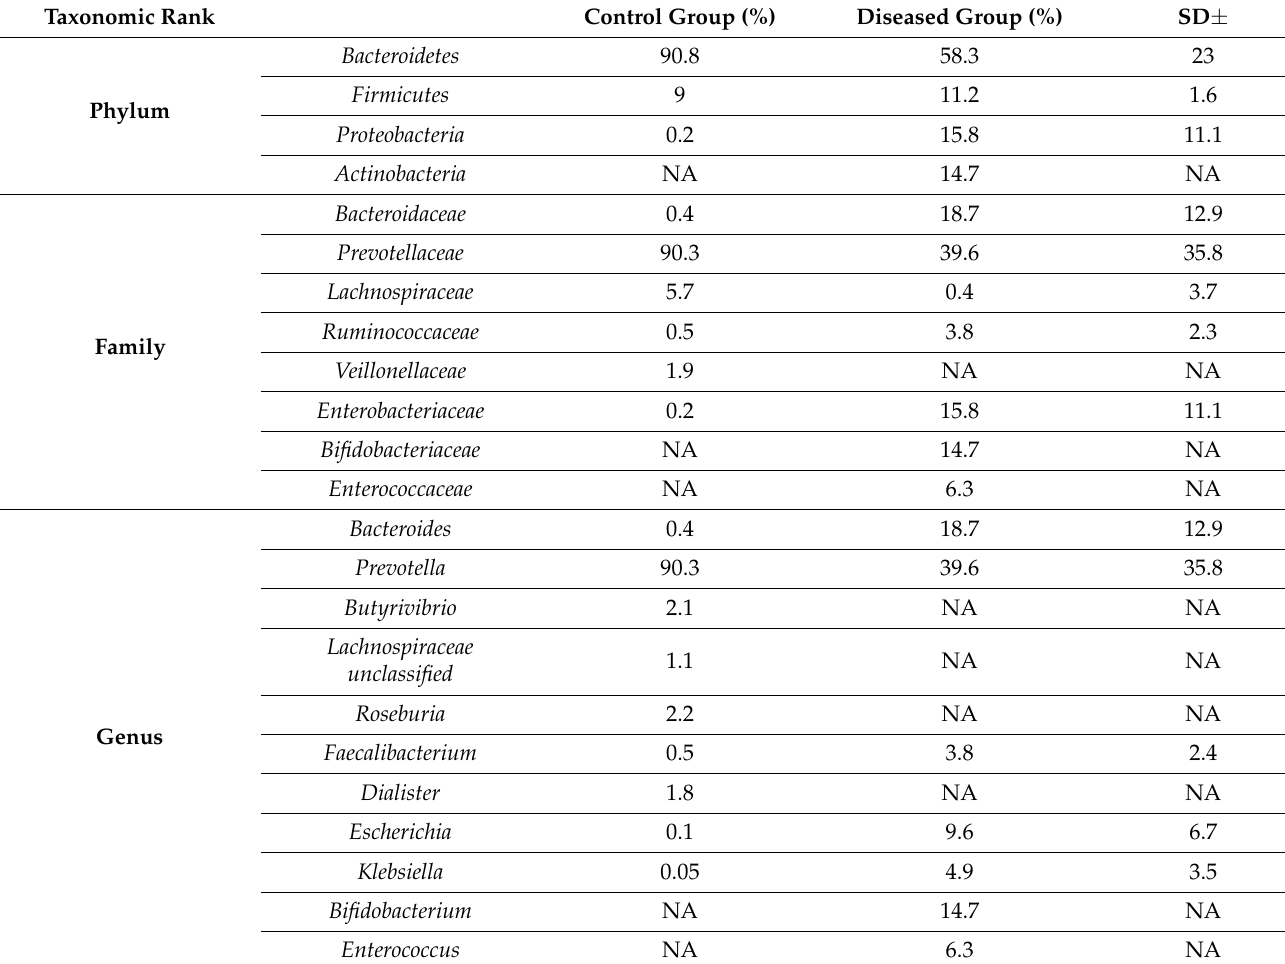
Table 1. Bacterial profiling fecal microbiota of healthy and diseased subjects were calculated using Metagenomic Phyloge- netic Analysis